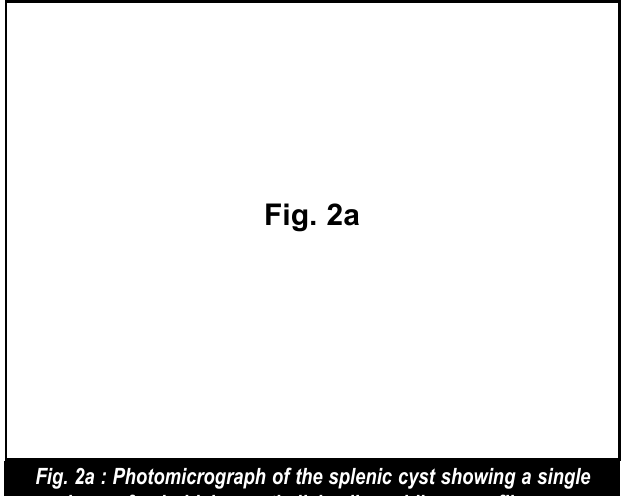
Fig. 2a : Photomicrograph of the splenic cyst showing a single layer of cuboidal mesothelial cells residing on a fibrous stroma and splenic parenchyma (H & E; X 40).